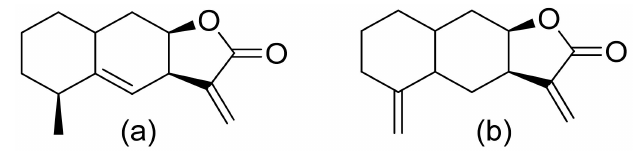
Figure 1. Lactones from sunflowers ( a , b